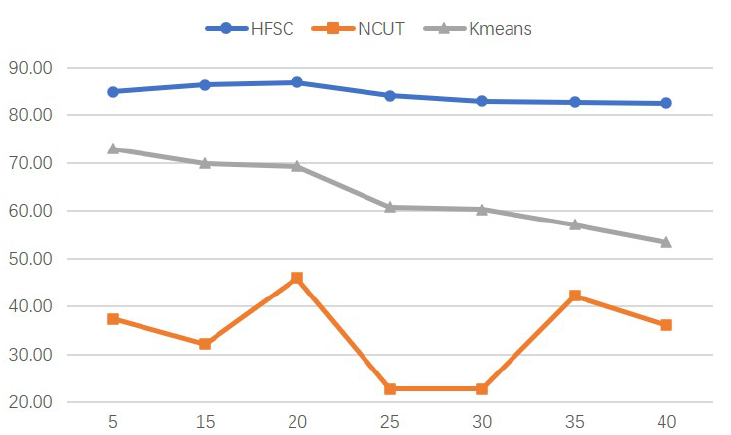
Figure 4. The clustering accuracy varies with the size of the defects. The diamond, square and triangle represent the HFSC, Ncut and Kmeans, respectively.